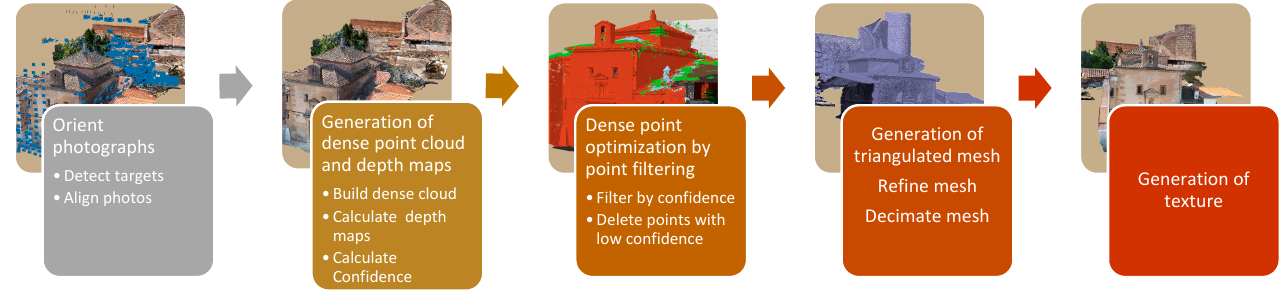
Figure 8. Photogrammetric processing of the data obtained by UAV.